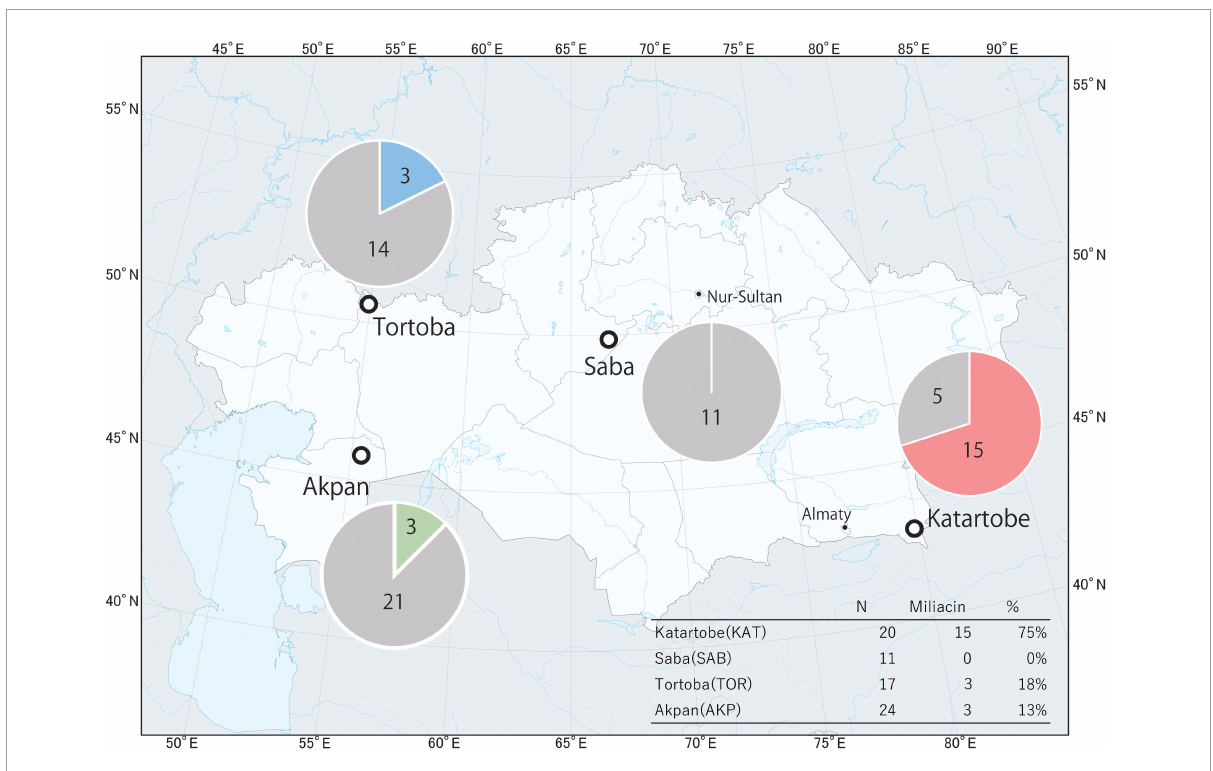
FIGURE6 The location of the sites studied and their percentage of miliacin detection per